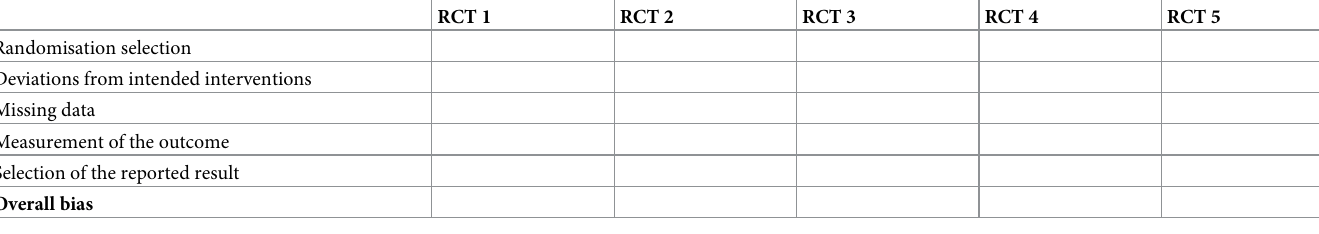
for assessing risk of bias (Table 3). RoB 2 will assess five domains, including randomisation process, deviations from intended interventions, missing outcome data, measurement of the outcome, selection of the reported result. Each domain will be judged as “low risk of bias,” “some concerns,” or “high risk of bias” by the answers (i.e., yes / probably yes / probably no / Table 3. RCT quality assessment according to the Cochrane risk-of-bias assessment tool (version